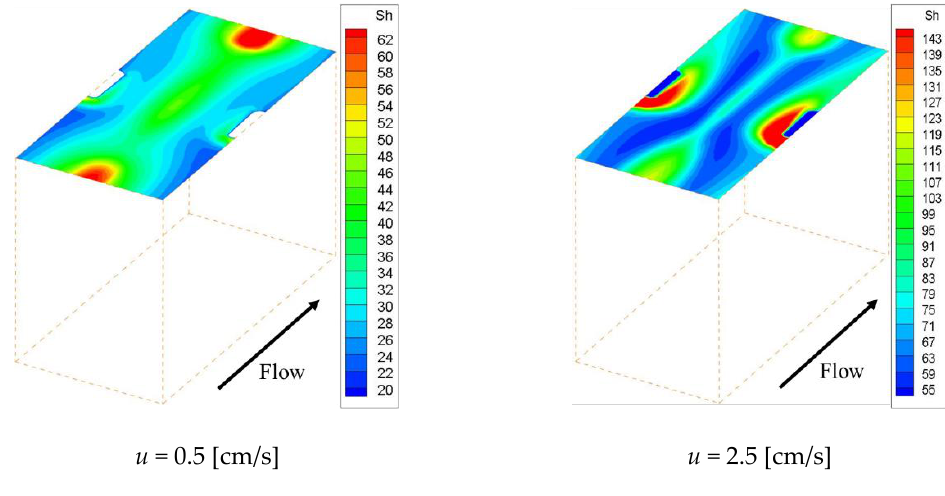
Figure 11. Effective Sherwood number distribution when using Spacer 4. The effective Sherwood number distribution is correlated with the concentration distribution on the membrane. The effective Sherwood number is high at places where the flow is disturbed around the structure, and the overall value is higher than that of the other spacers.